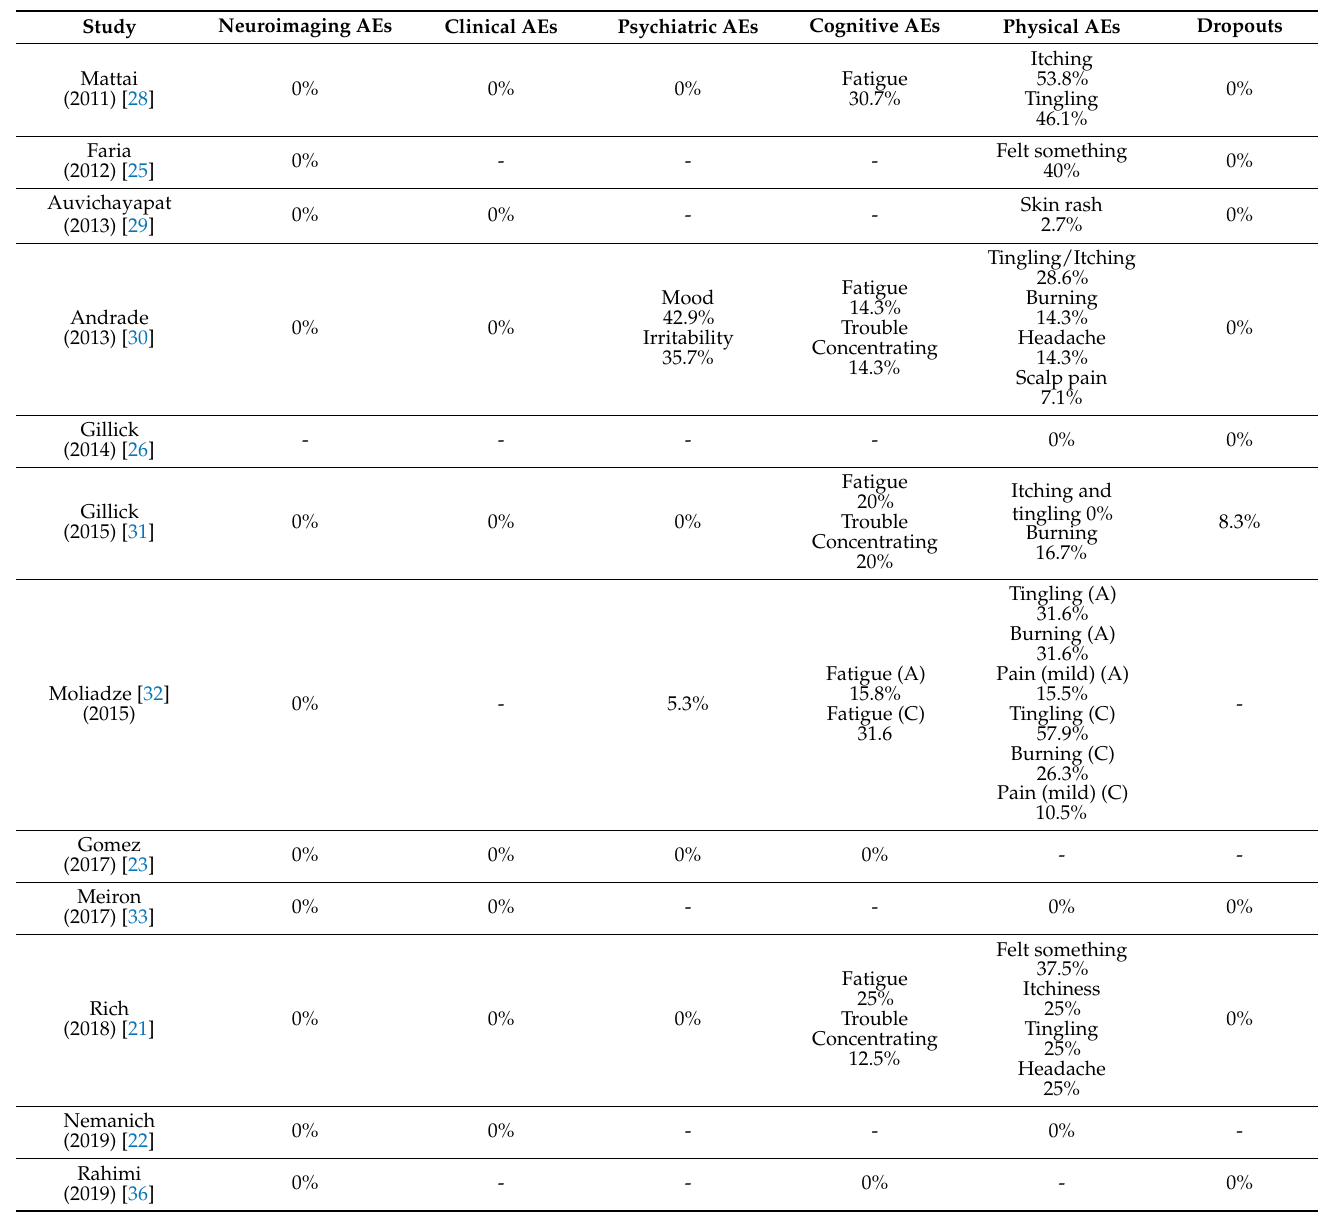
Table 4. Adverse events reports.